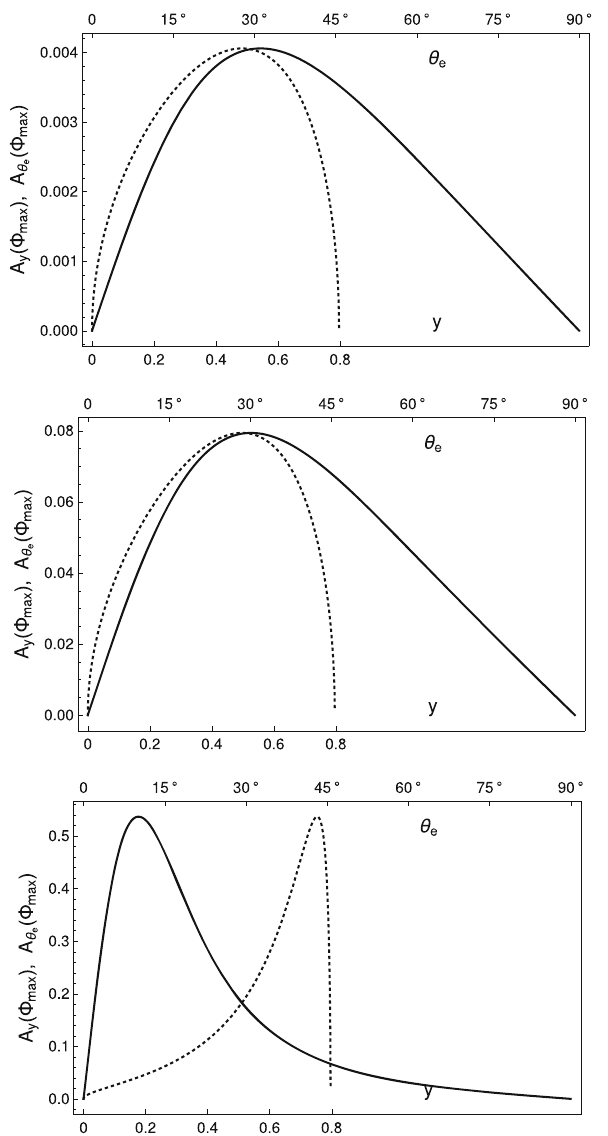
Fig. 2 Dirac(orMajorana) ν e with V – A interaction:plotof A y (Φ max ) (Φ ) as a function of θ as a function y (dotted line) and A θ max e (solid e line) for ˆ η ν · ˆ q = − 1, E ν = 1 MeV , Φ max = π/ 2: upper plot for θ = 0 . 1; middle plot for θ = π/ 2; lower plot for θ = π − 0 . 1 1 1 1 ( ˆ η ) ⊥ ); by Φ e max we denote the location of their max-